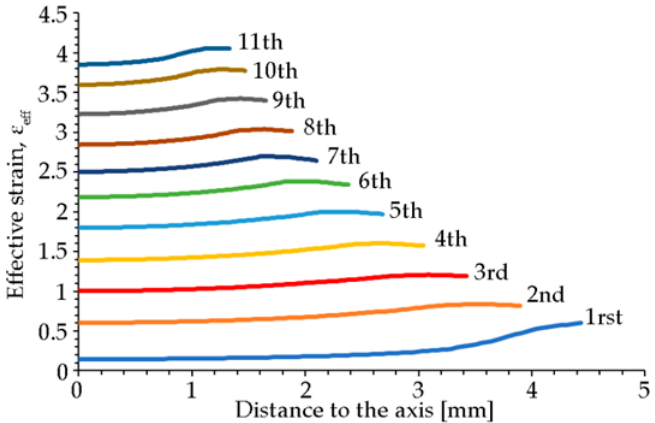
Figure 11. Effective strain distribution curves in the section of the wire, for each of the wiredrawing stages.